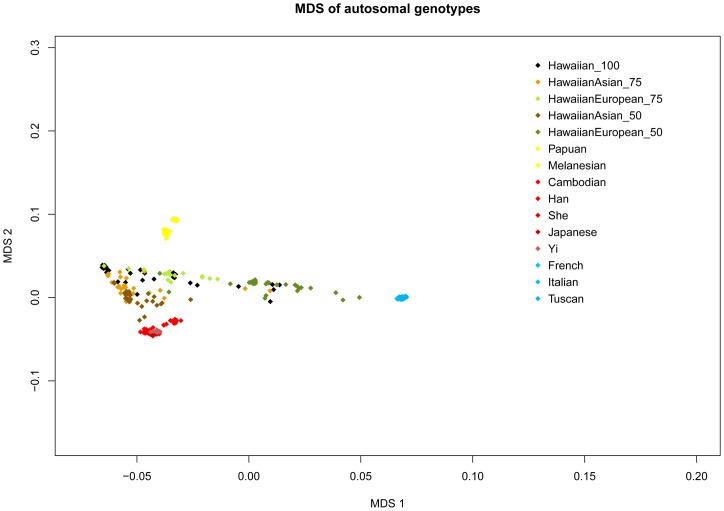
Multi-Dimensional Scaling analysis of GWAS data.HGDP representative samples with European, East Asian and Oceanian ancestry and are plotted against Native Hawaiians with various degrees of self-reported ancestry in MDS dimensions.